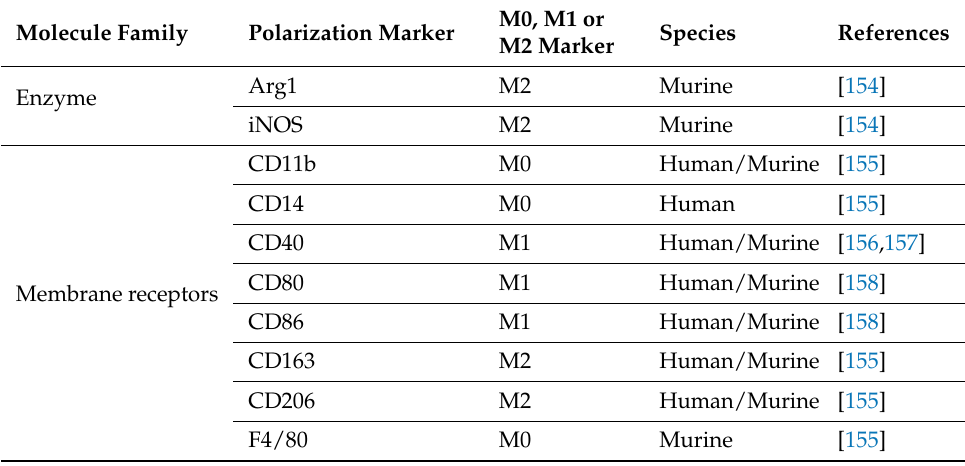
Table 2. Markers of macrophage polarization. Molecule